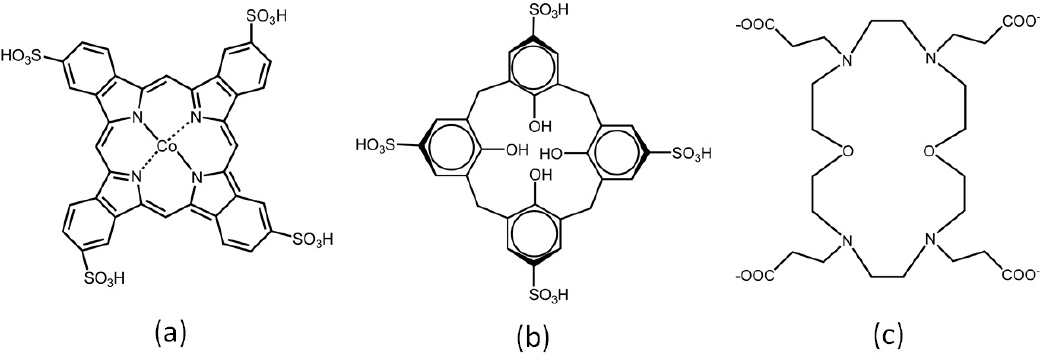
Figure 5. Structure of: ( a ) Co(II) tetrasulfophthalocyanine; ( b ) Carboxyethyl substituted azacrown ether derivative (CSAE); ( c ) p -sulfonated calixarene.